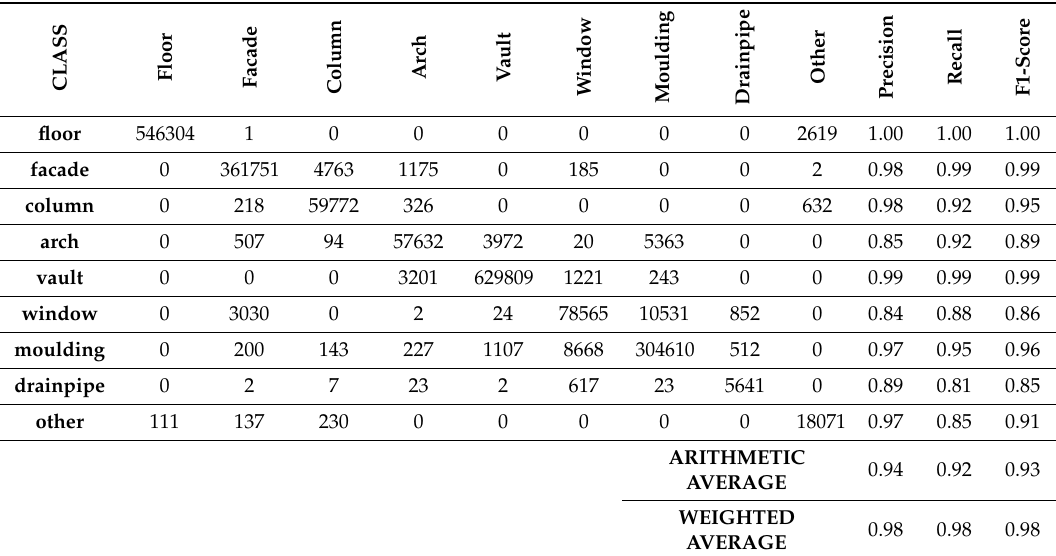
Table 3. Evaluation metrics: generalisation level #1, within dataset A.